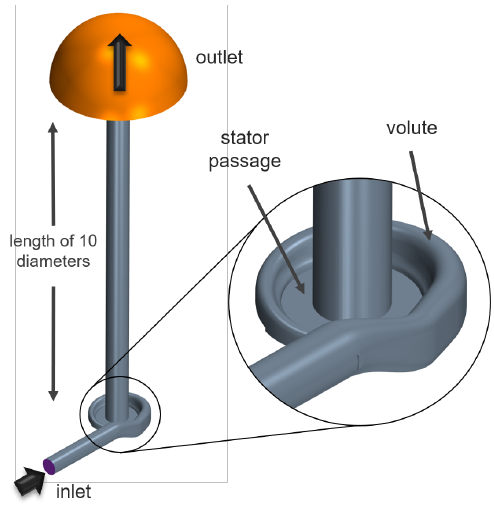
Figure 2. Computational